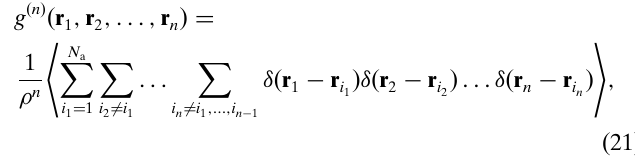
¼ 10 4 , there is good agreement (cid:3)